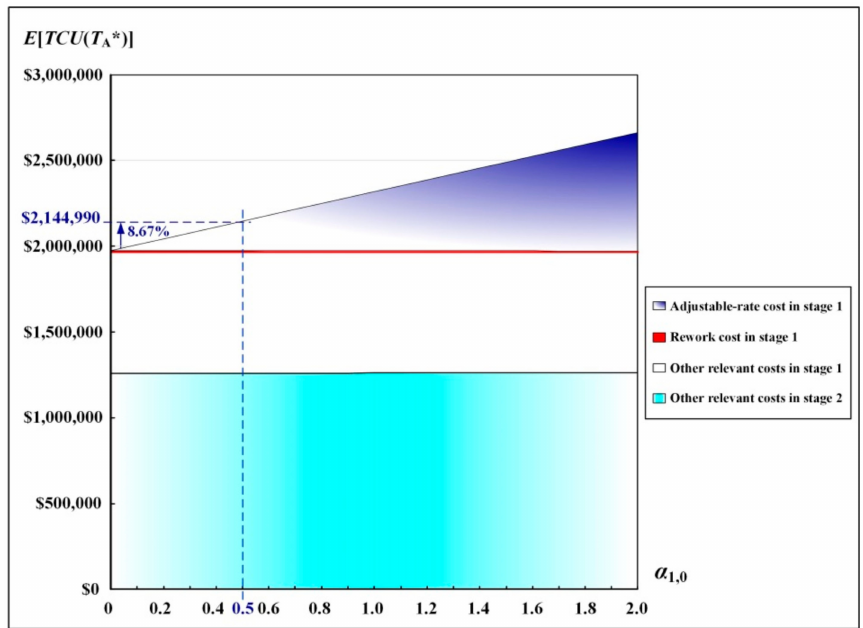
Figure 12. The impact of adjustable-rate factor on various cost